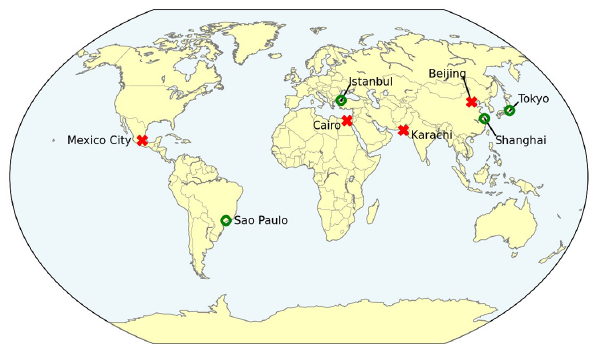
Figure 7. Summary of conclusions reached after applying the re- sults of the viscosities, diffusion coefficients, and mixing time of the toluene-derived SOM to the top 15 most populous megacities. Green circles indicate megacities where the afternoon RH at the 10th percentile does not go below 45%RH and the median after- noon temperature is 290–300K for certain times of the year. In these cases, well-mixed particles can be assumed. Red crosses indicate megacities where the afternoon RH at the 10th percentile is 17% or lower for certain times of the year and the median afternoon tem- perature is 290–300K. In these cases, the particles may not be well mixed in the afternoon for certain times of the